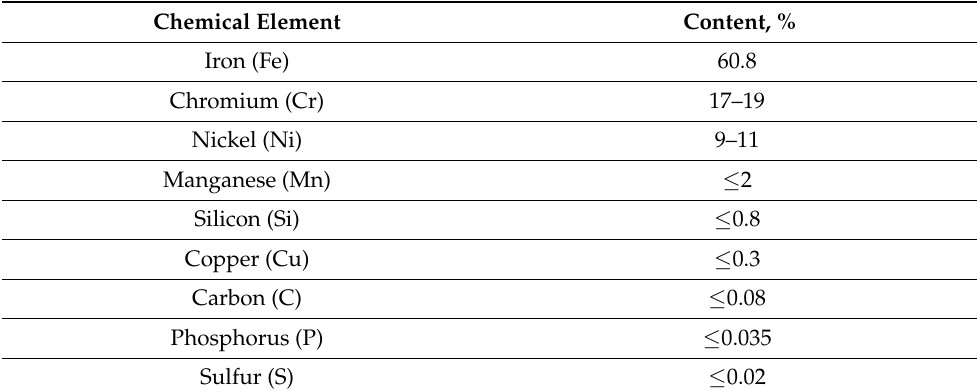
Table 1. Chemical composition of Art.